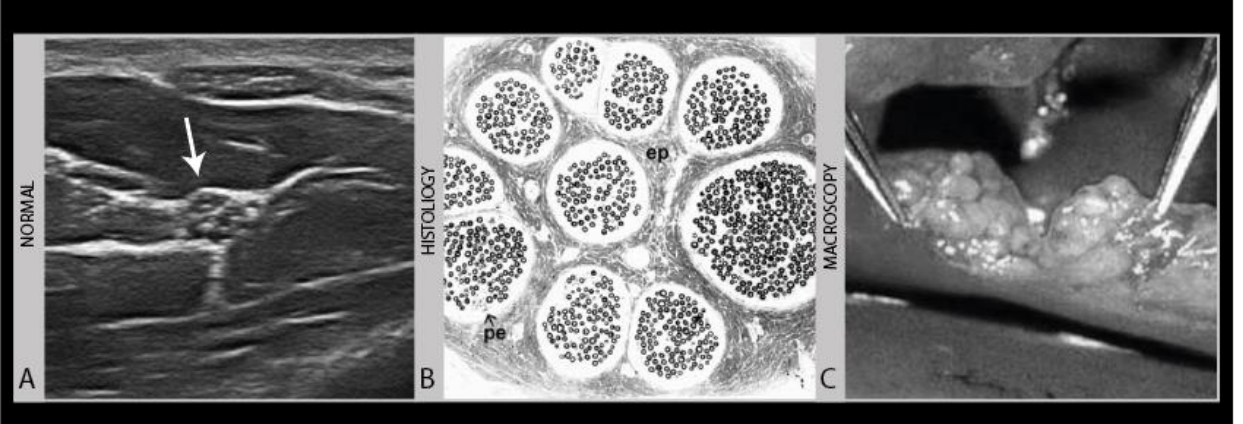
Figure 1. Normal transverse image of the median nerve mid-forearm ( A ), in comparison to a gross histology image ( B ) and the surgical appearance of a cut nerve ( C ).